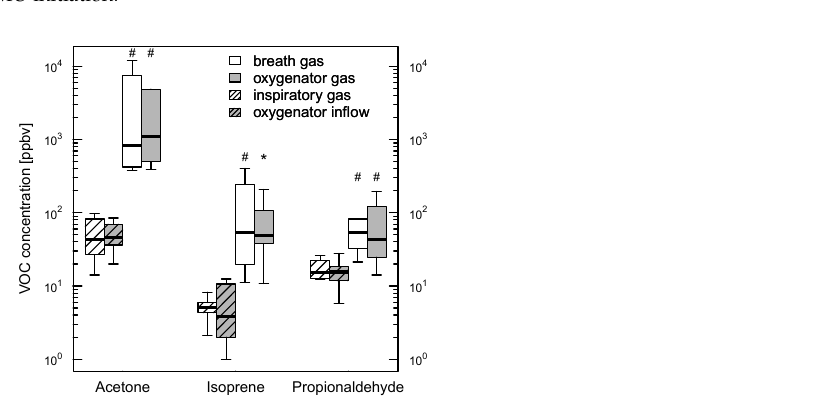
Figure 1. Breath and oxygenator gas VOC content. Concentrations of acetone, isoprene, and propionaldehyde in breath and extracorporeal membrane oxygenator gas on day one of measurements. Note that the concentrations found in oxygenator outflow gas are comparable to those found in exhaled breath (VOC, volatile organic compound). Intragroup comparisons with Wilcoxon signed-rank test. # p < 0.005; * p < 0.01.